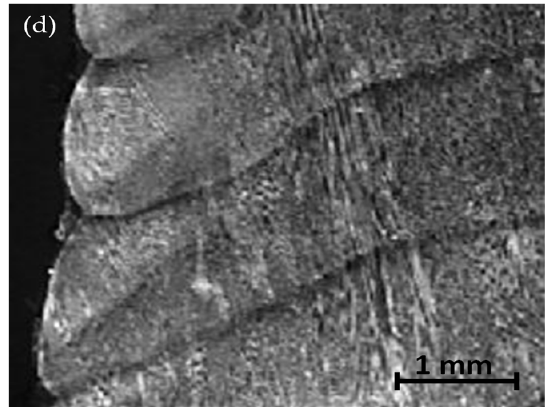
Figure 13. Cross-section of conventional PTA ( a ), parallel configuration tandem PTA ( b ), high magnification of the area A ( c ), and area B ( d ) [21].